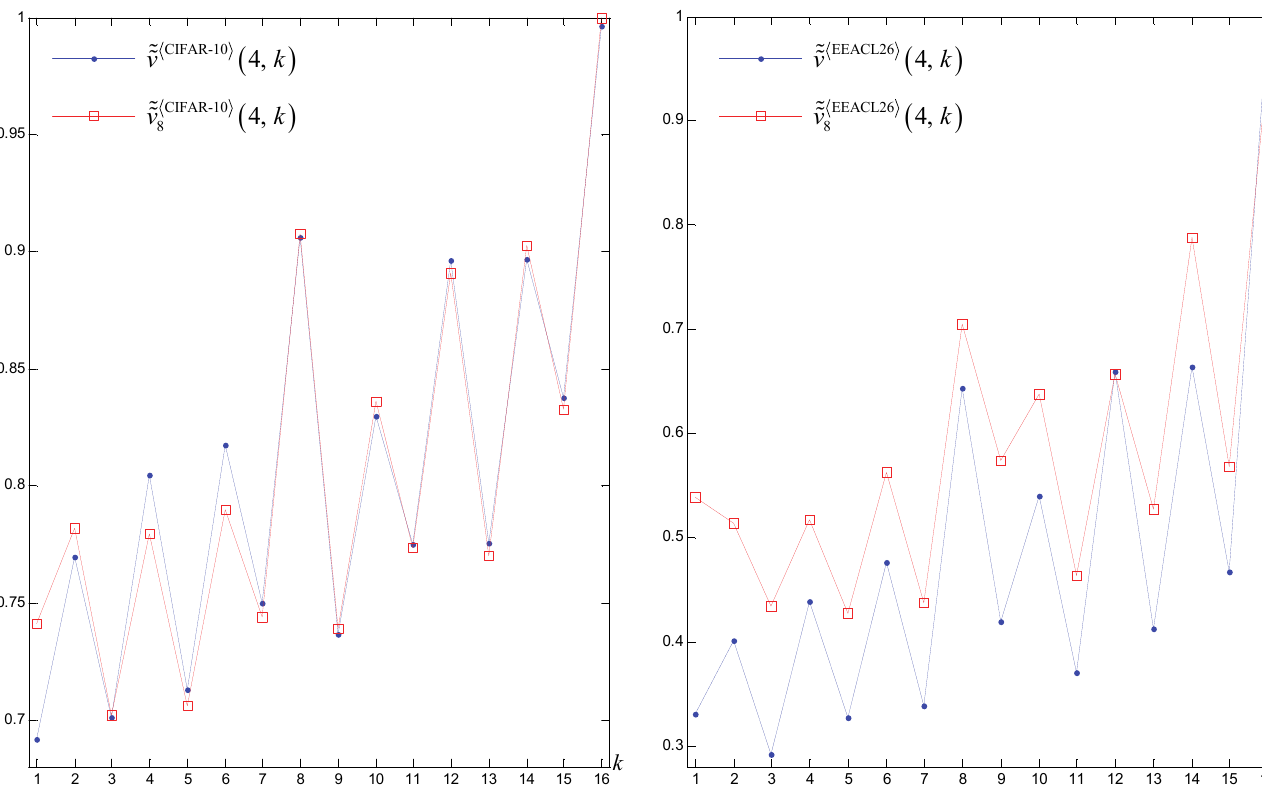
Fig. 6. Performance of CNNs with 4 ConvLs on EEACL26. Minimum points of these polylines are different ( k = 3 and k = 5), but still close to each other. The minimum of (9) is undisguised now. The peaks repeat themselves.